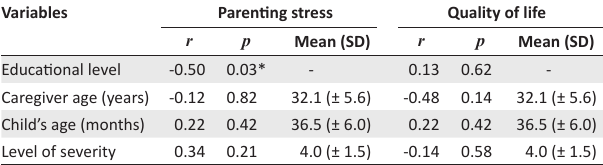
TABLE 5: Factors influencing primary caregiver stress and quality of life.